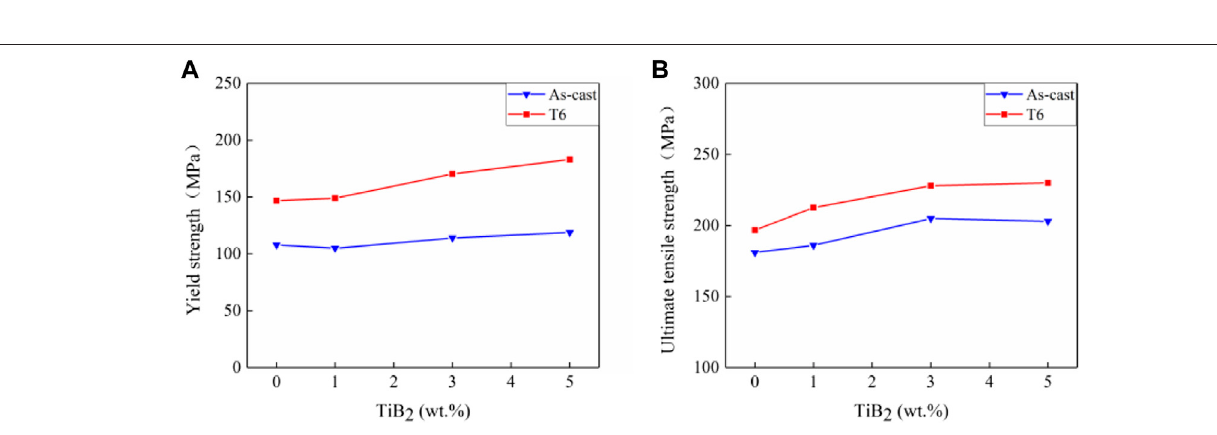
Frontiers in Materials |